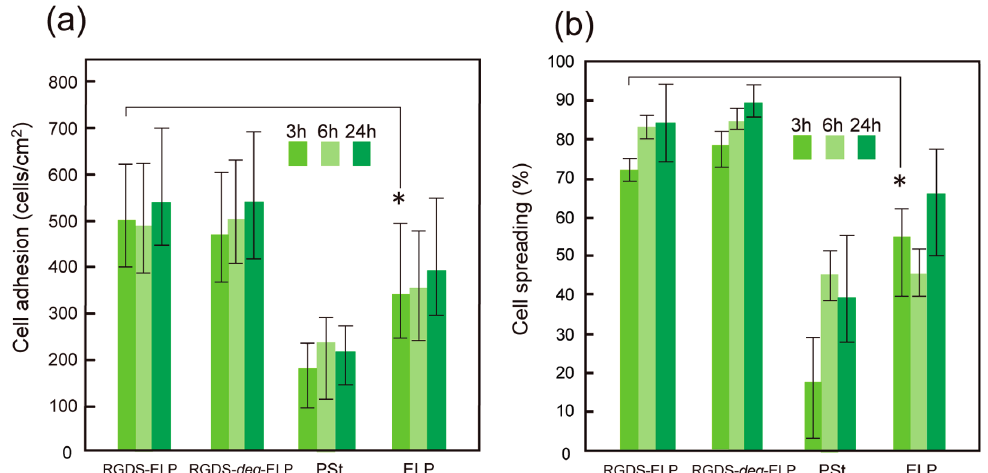
Figure 5. ( a ) Cell adhesion and ( b ) degree of cell spreading of NIH/3T3 onto molecular layers of RGDS-ELP, RGDS- deg -ELP, epitope-free oligo(ELP) and un-coated PSt at 3, 6, 24 h. Statistical analyses were performed with a Student’s t -test. * p < 0.05.